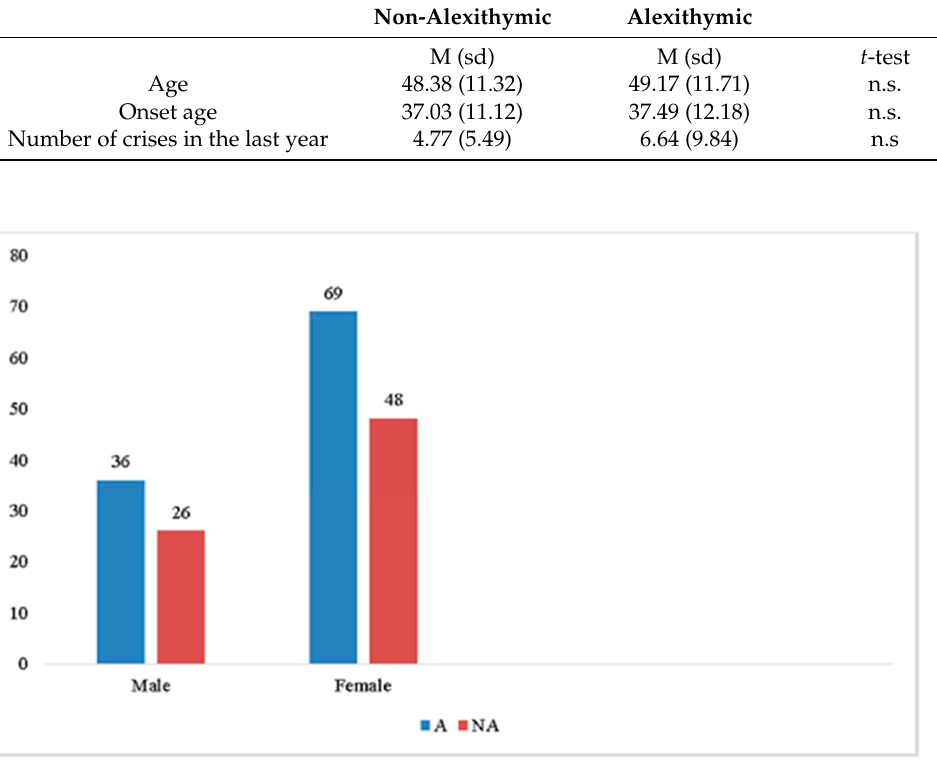
Figure 1. Gender comparison between A (Alexithymic) and NA (Non Alexithymic) groups by Figure 1. gender comparison between A (Alexithymic) and NA (Non Alexithymic) groups by Pearson chi-square Pearson chi-square test. Table 4. age and Menière syndrome’s features comparison between A and NA groups by t-test.